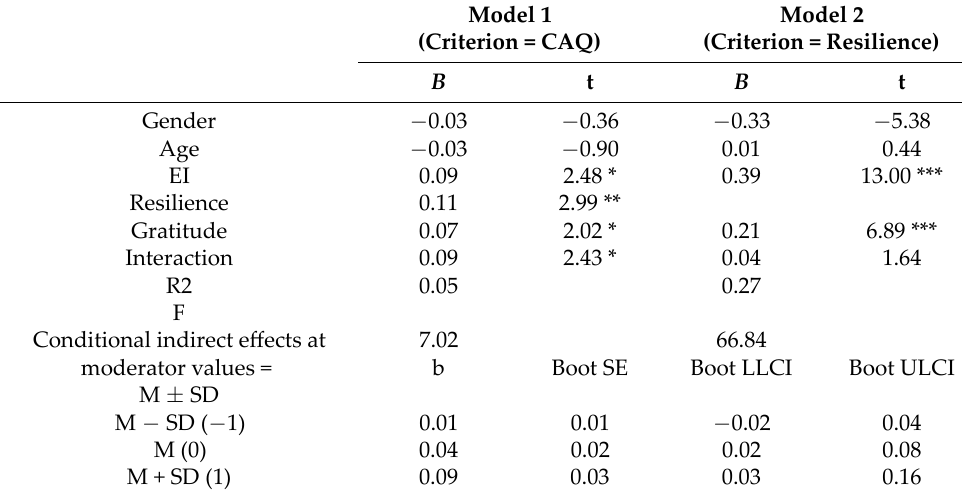
Figure 1. Mediation analyses. Note: Full items are listed by abbreviations. EI—emotional intelli ‐ gence; CAQ—CAQ score. ** p < 0.01; *** p < 0.001.